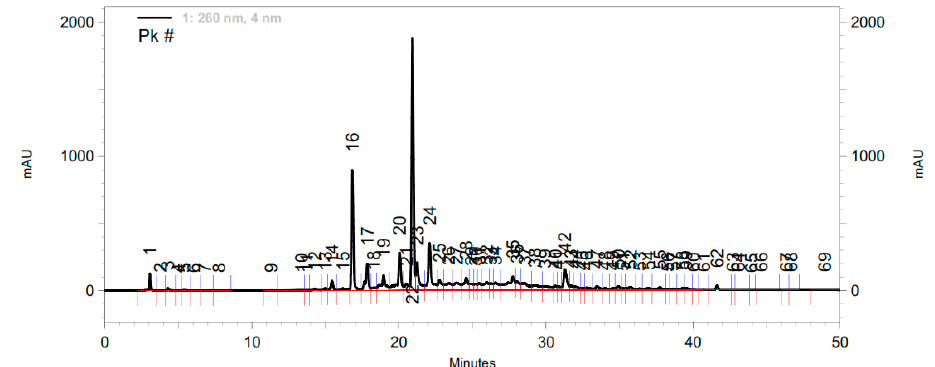
Figure 2. HPLC-DAD-UV (260 nm) phenolic pro fi le of the methanolic extract from leaves of P.